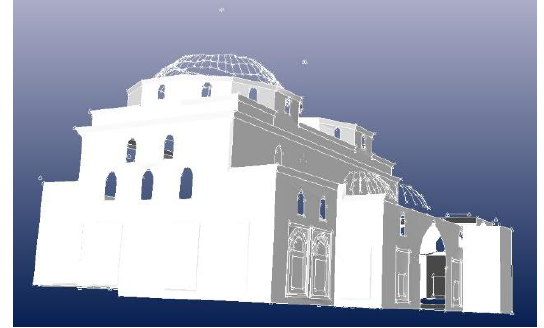
Figure 7. Drawings and Mosque’s columns